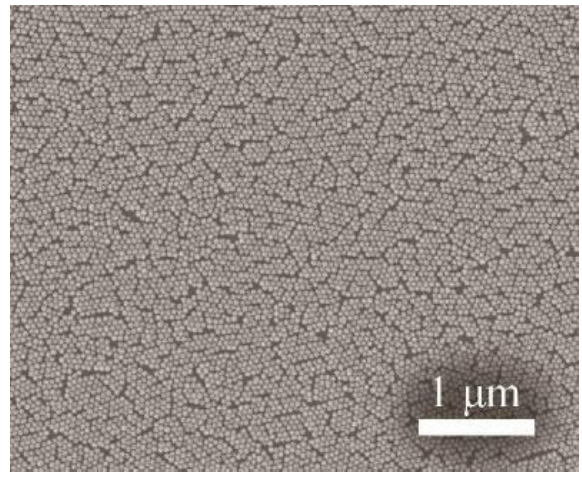
Figure 2. Scanning electron microscopy (SEM) image of a monolayer of SiO 2 nanospheres (50 nm) covered by 20 nm of Au.